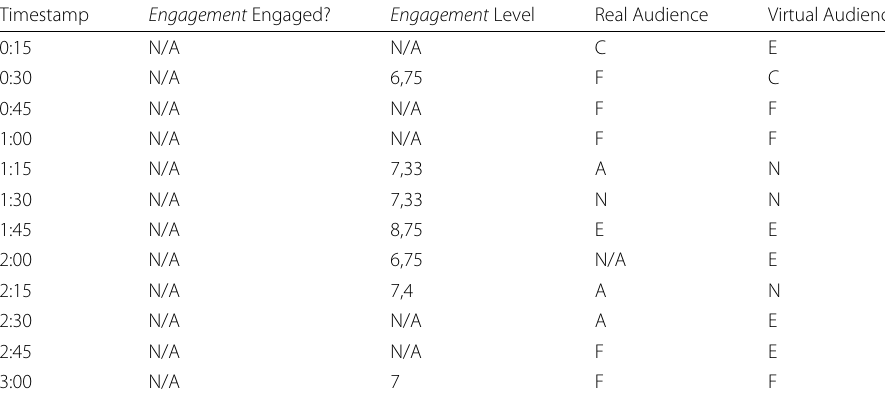
Table 4 Experiment: Results from speech #1